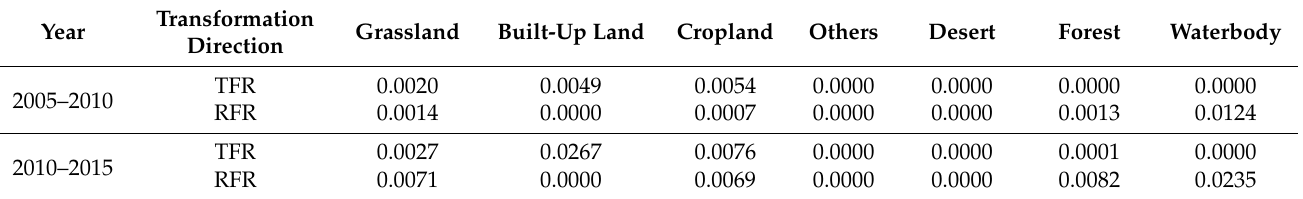
Table 7. Forward/reverse transformation rate in the Loess Plateau Ecological Screen in 2005~2010,